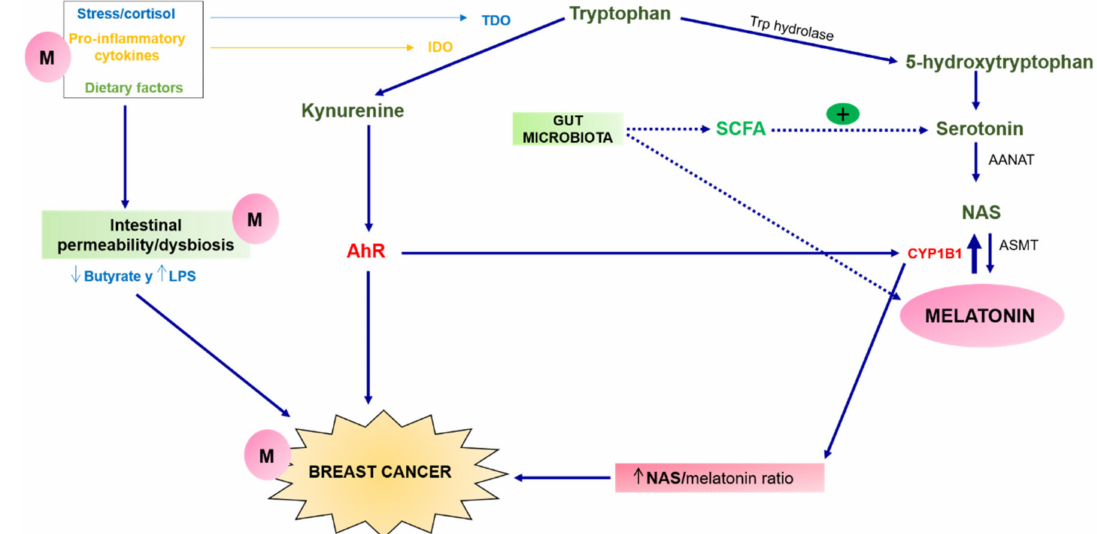
Figure 1. Melatonergic and kynurenine pathways. The activation of TDO by stress and cortisol, and IDO by pro- inflammatory cytokines, leads to an increase in the kynurenine pathway which implies the conversion of tryptophan into kynurenine and kynurenic acid, which can activate the AhR, leading to important changes in breast cancer cells, including a marked increase in mitochondrial CYP1B1. Mitochondrial CYP1B1 drives melatonin conversion to NAS, increasing the NAS in the NAS/melatonin ratio, which is implicated in an increased risk of breast cancer. Conversely, SCFA, produced by gut microbiota, directly or indirectly stimulates the production of melatonin by stimulating the production of serotonin which is then converted into melatonin. Gut dysbiosis and gut permeability decrease butyrate levels and increase LPS levels, favouring the appearance of breast cancer. Melatonin can counteract this effect caused by dysbiosis, preventing breast cancer. Abbreviations: AANAT: aralkylamine N-acetyltransferase; AhR; aryl hydrocarbon receptor;